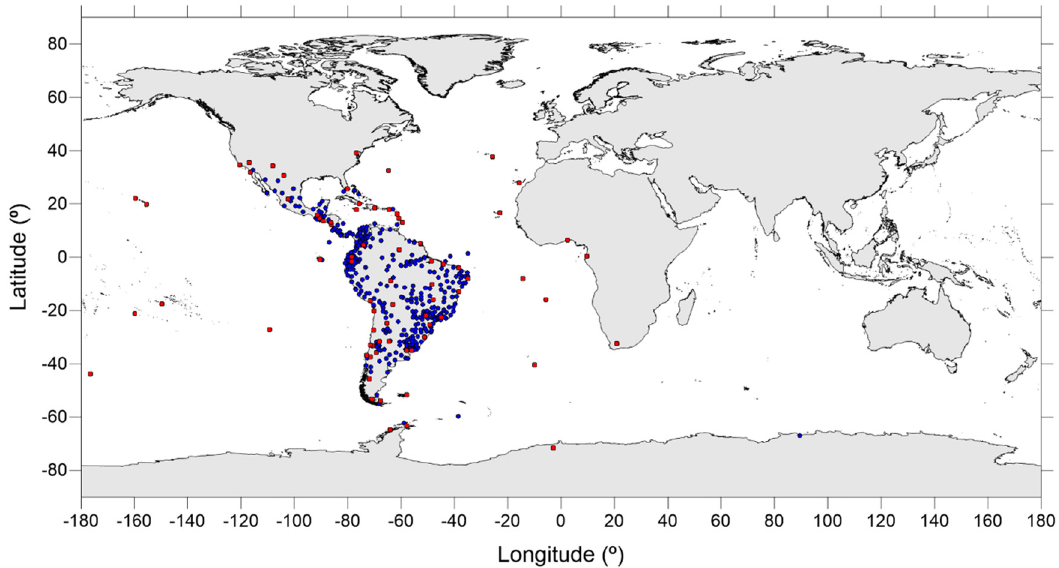
Figure 1: SIRGAS - CON stations represented in blue points and SIRGAS - CON stations common to IGS in red